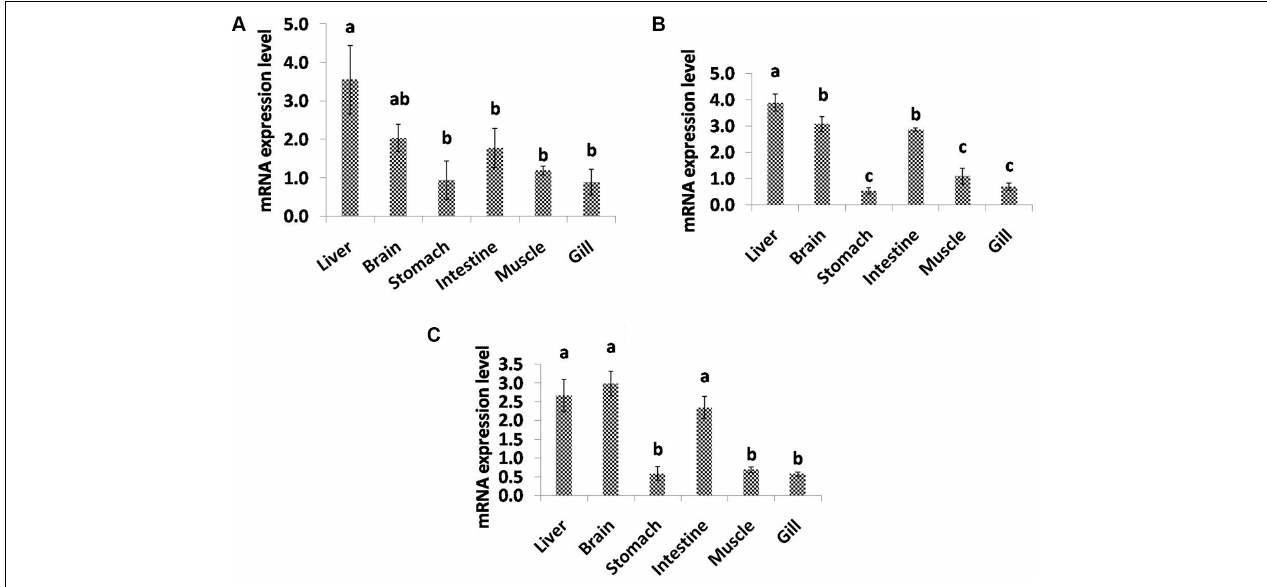
FIGURE 5 | Quantitative analysis of the relative mRNA expression levels of FADS2 (A) , FADS5 (B), and ELOV (C) in different tissues of C. magur . Data (mean ± SEM, n = 3) were expressed relative to expression of β -actin gene. Groups with different letters were significantly ( P < 0.05)